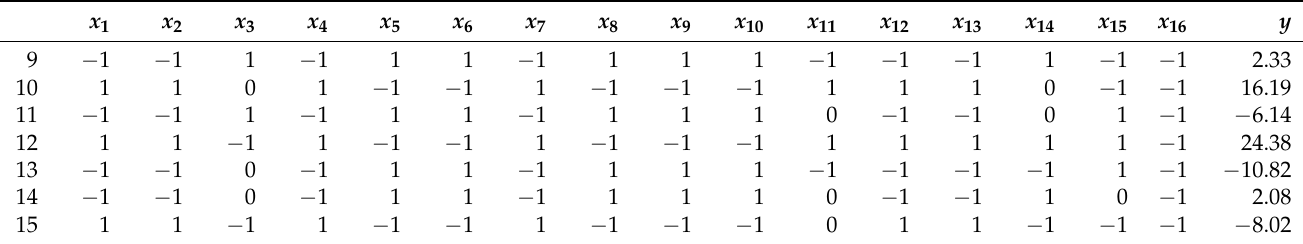
Table 2. Additional seven runs of the BD-CAD for the SSD ( 8,13 )